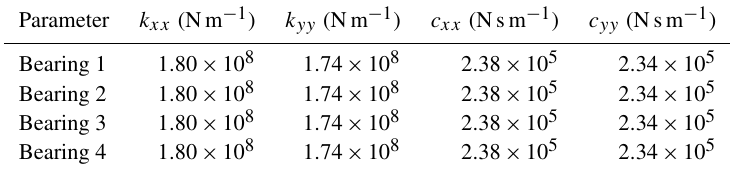
Table 1. Support stiffness and damping of the gear-rotor